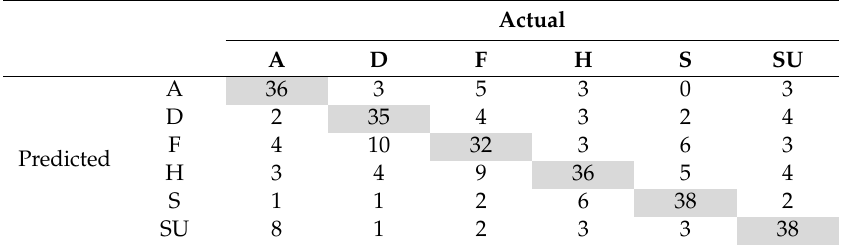
Table 5. Confusion matrix of the RBD group using the H 3 feature in KNN classification.